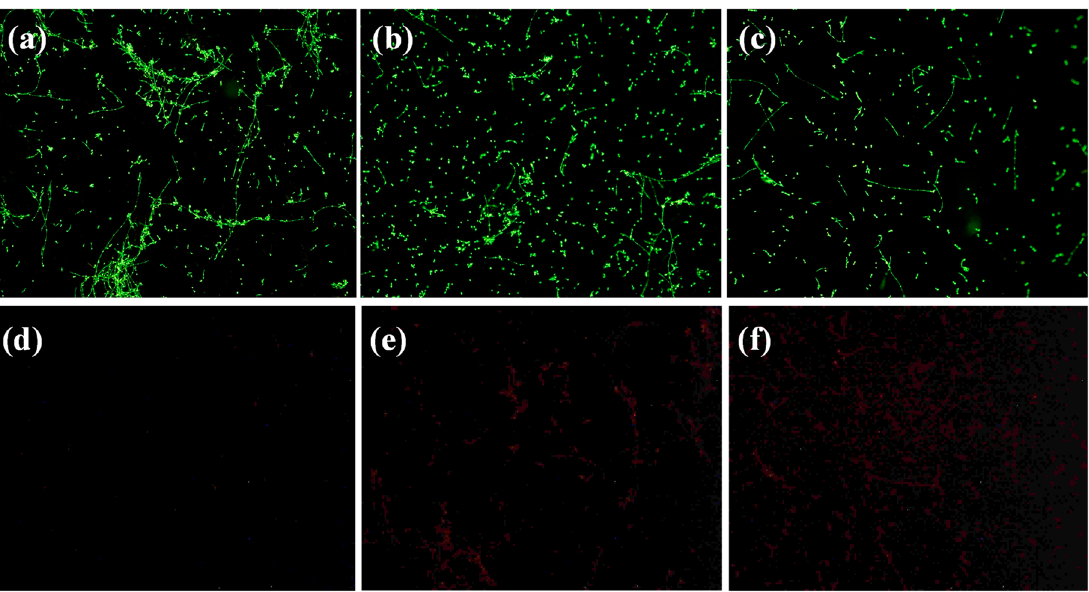
Figure 8. Fluorescent microscope images of Candida albicans biofilms, showing ( a–c ) live cell Figure8. Fluorescentmicroscopeimagesof Candidaalbicans biofilms, showing( a–c )livecelldistributions distributions and ( d–f ) dead cell distributions. ( a , d ) Control biofilms, ( b , e ) biofilms treated with ZnFe 2 O 4 @AgNWs hybrid nanostructures for 12 h, ( c , f ) biofilms treated with ZnFe 2 O 4 @AgNWs hybrid